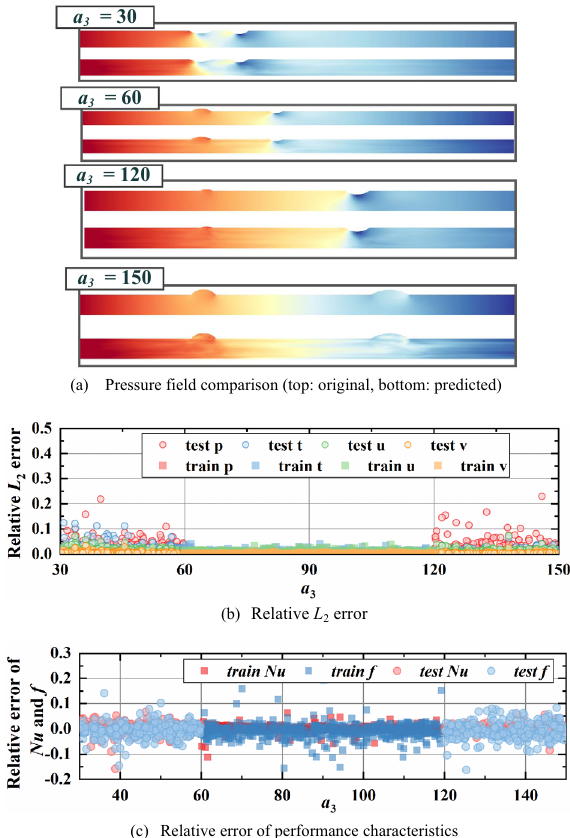
Figure 15. Extrapolation performance of a 3